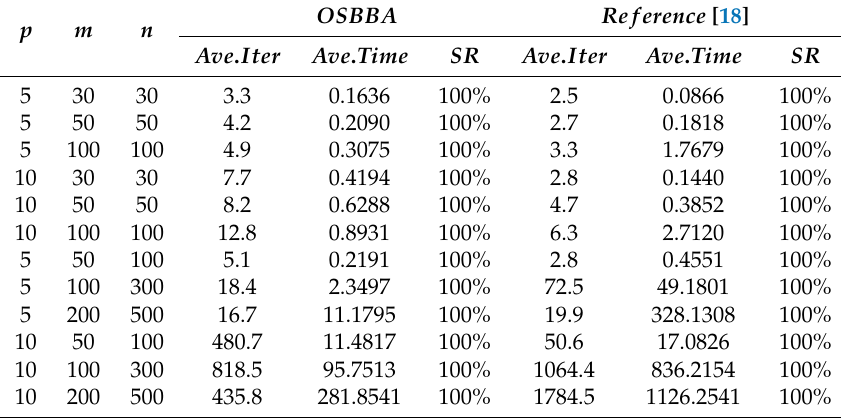
Table 2. The results of random calculations for Example 12. Ave.Iter, the average number of iterations on problems 12–13; Ave.Time, the average CPU running time of problems 12–13; SR , the success rate of the algorithm in calculating problem